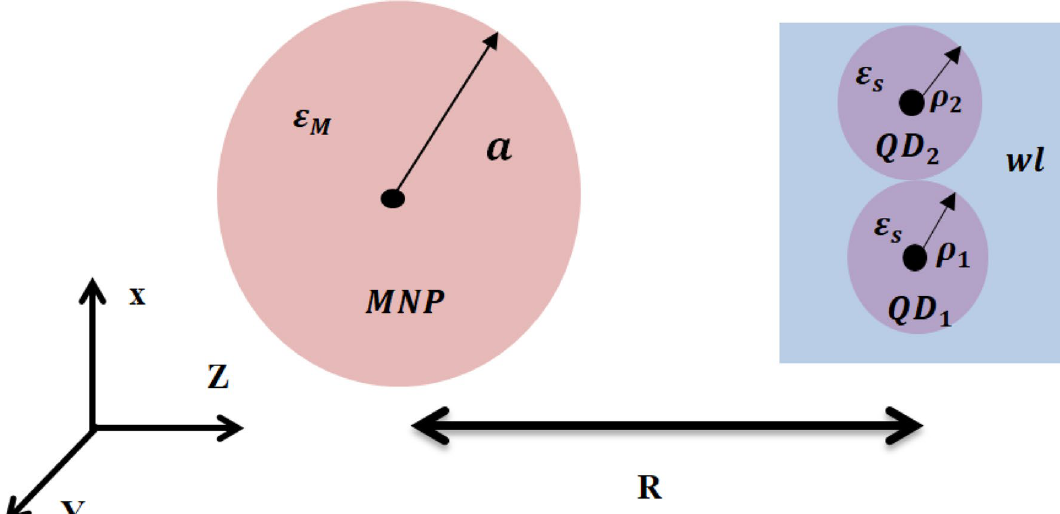
Figure 1. The hybrid DQD-MNP system. The separation between the centers of the two particles is